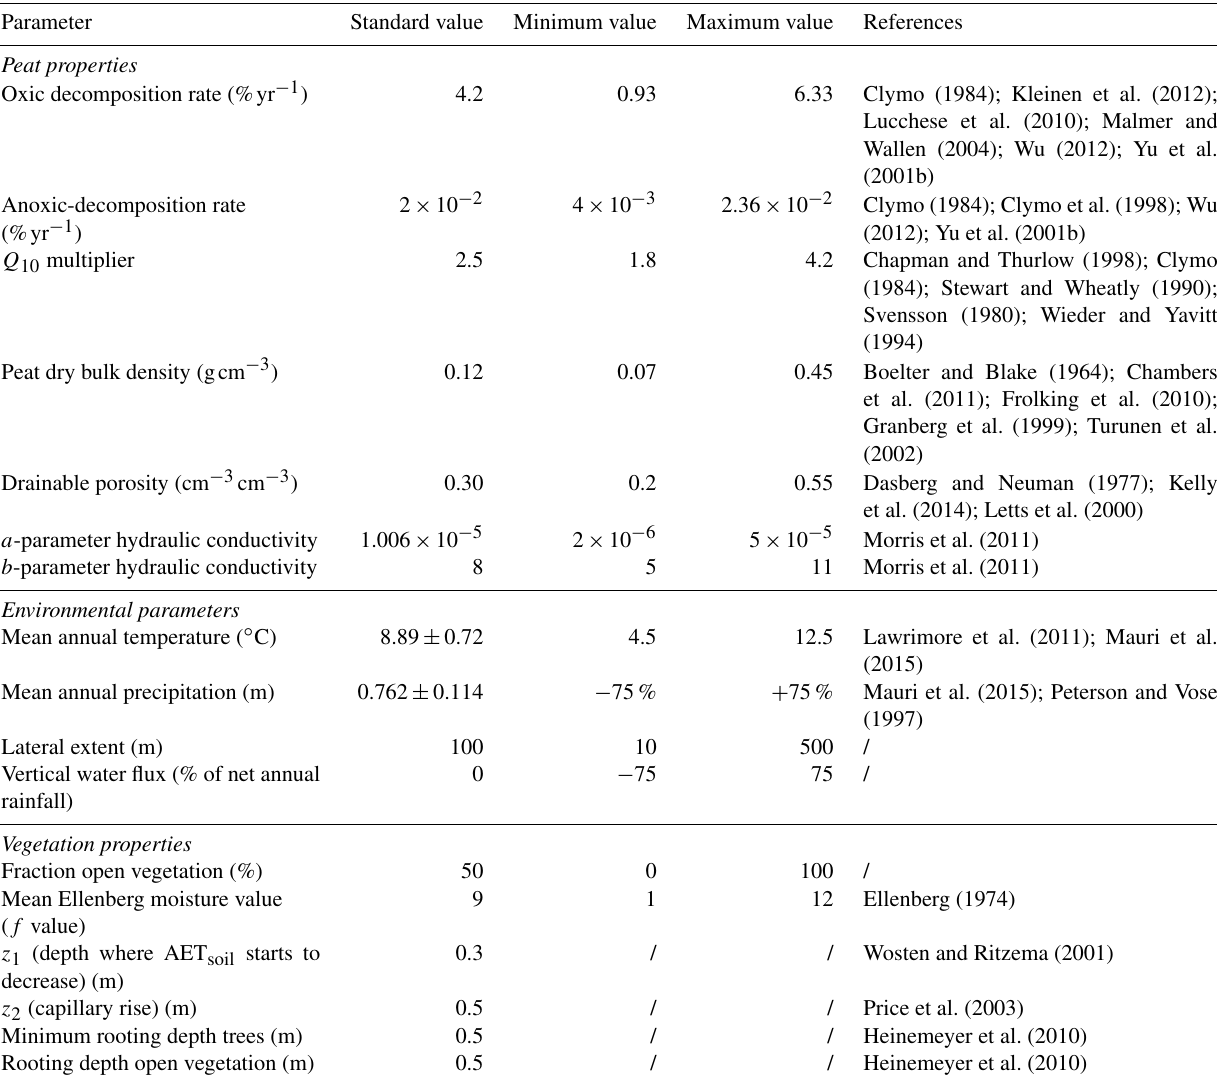
Table A6. Overview of the parameters used in the parameter sensitivity test, listing the standard value and the range over which the parameter is